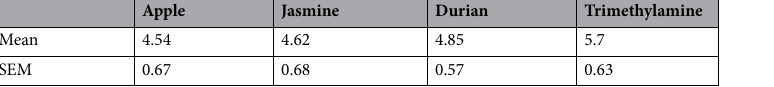
Table 6. Mean and SEM of participants’ hunger level in each odor session. Hunger level was evaluated using a visual analog scale ranging from 0 (“not hungry at all”) to 10 (“very